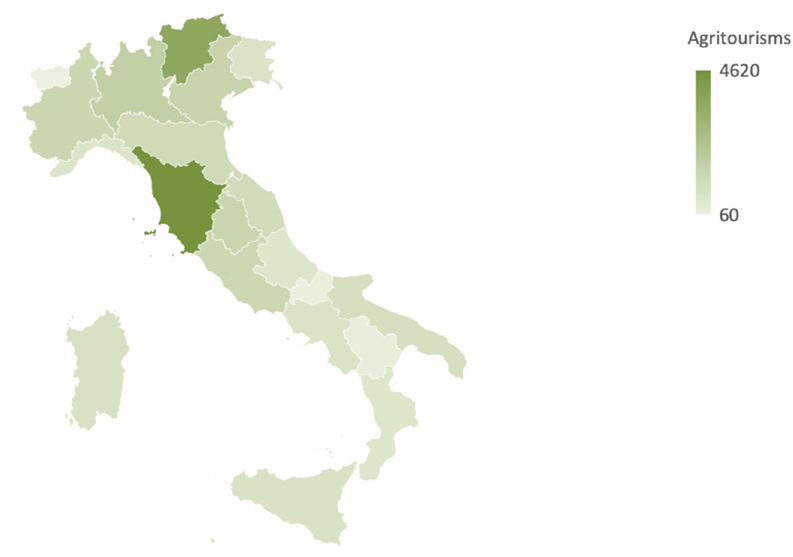
Figure 2. Concentrations of agritourism in Italy. Elaboration based on ISTAT 2019 [2].